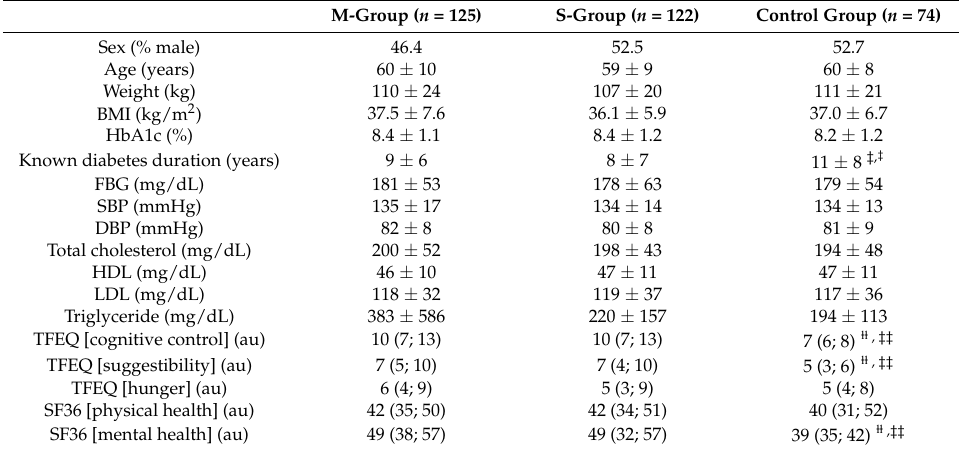
Table 1. Baseline characteristics of the participants who finished the 12-week diet intervention.